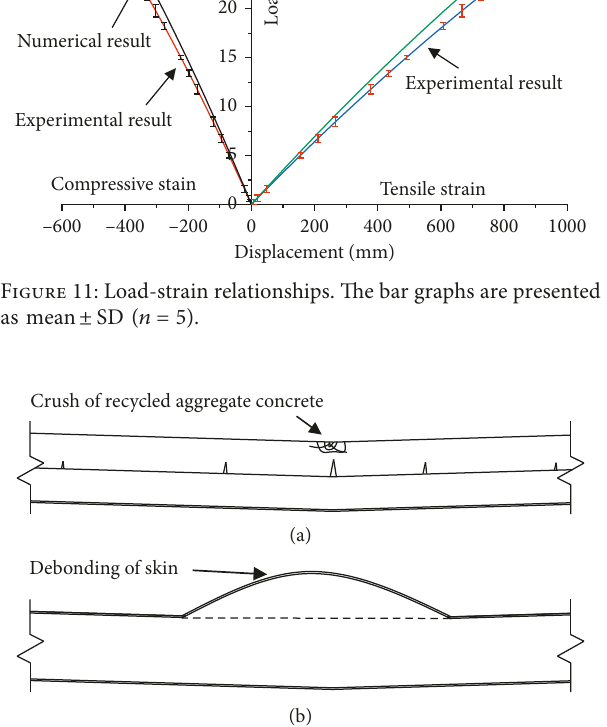
Figure 12: Failure modes of ICSIP and CSIP: (a) crush of recycled aggregate concrete for ICSIP; (b) debonding of skin for